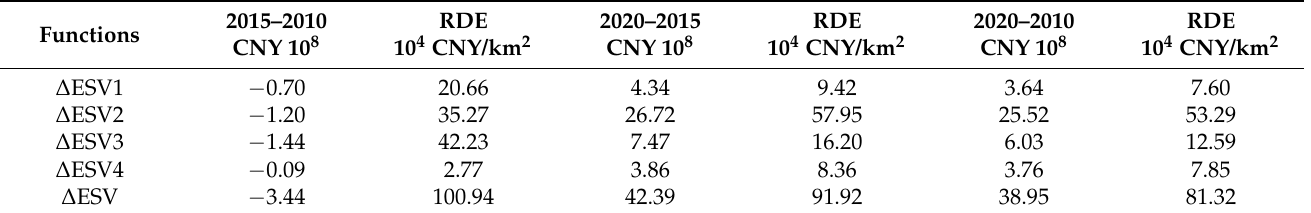
Table 4. Changes in ecosystem service value and its response to land cover change according to ecosystem service function types.